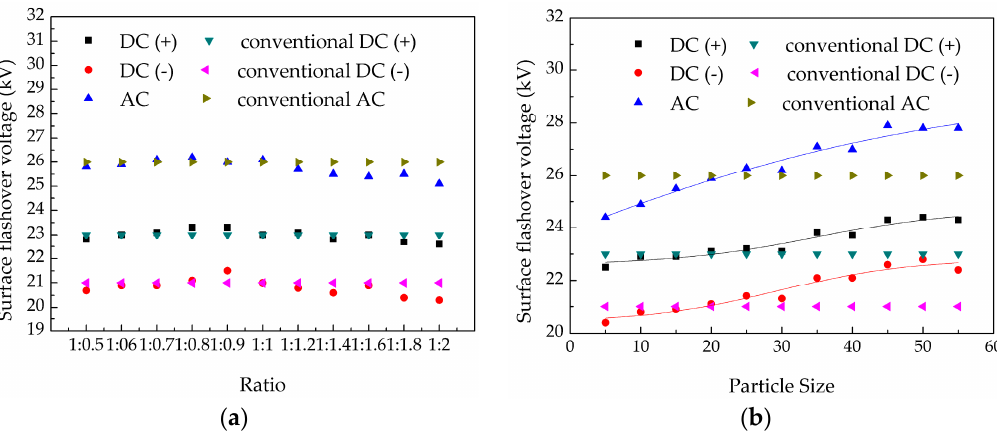
Figure 11. Surface flashover comparative test with traditional simulation contamination ( a ) change the soluble ingredients ( b ) change the insoluble ingredients